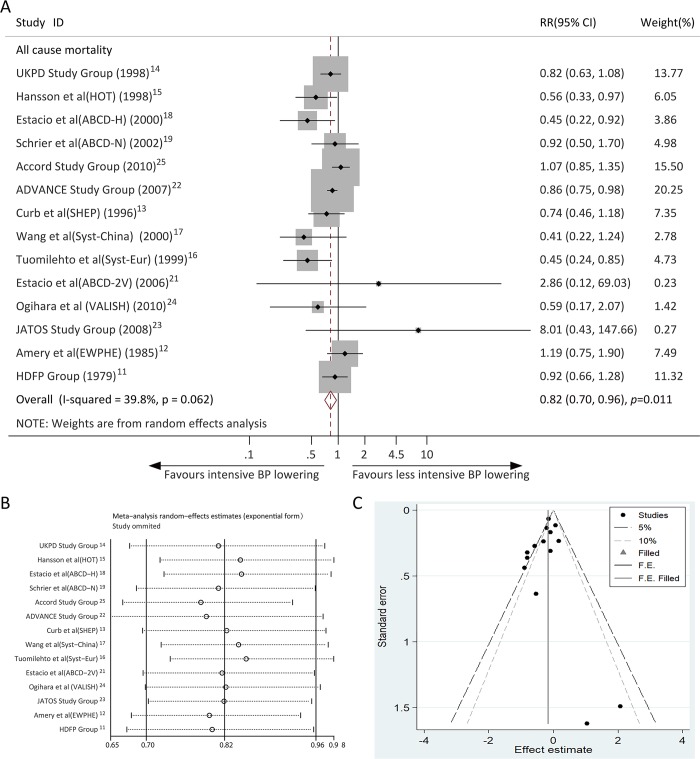
(A) Forest plot showing the effects of intensive versus less intensive blood pressure lowering treatment on all-cause mortality; (B) Plot of sensitivity analysis by excluding one study each time and the pooling estimate for the rest of the studies; (C) Funnel plot of publication bias test.